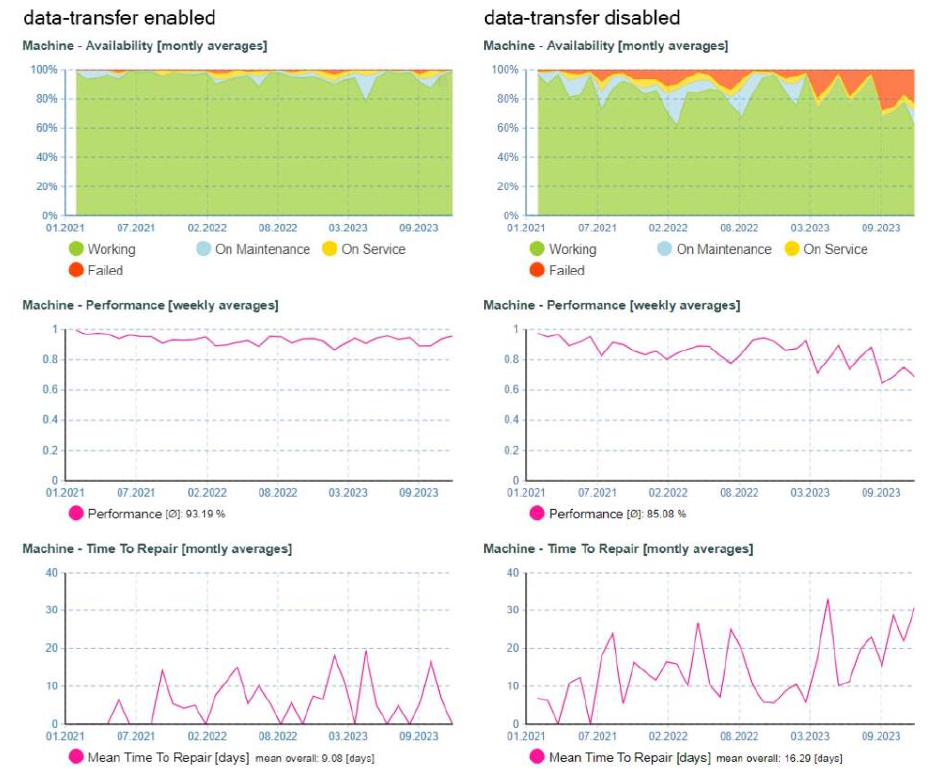
Fig. 5. Comparison of enabled (left) and disabled (right) data-sharing of a single simulation run in the demonstrator. The time stack chart on top shows the monthly averages of states of all machines of the installed base, the line chart in the middle shows the weekly average performance and the line chart at the bottom shows the monthly average time to repair or downtime of